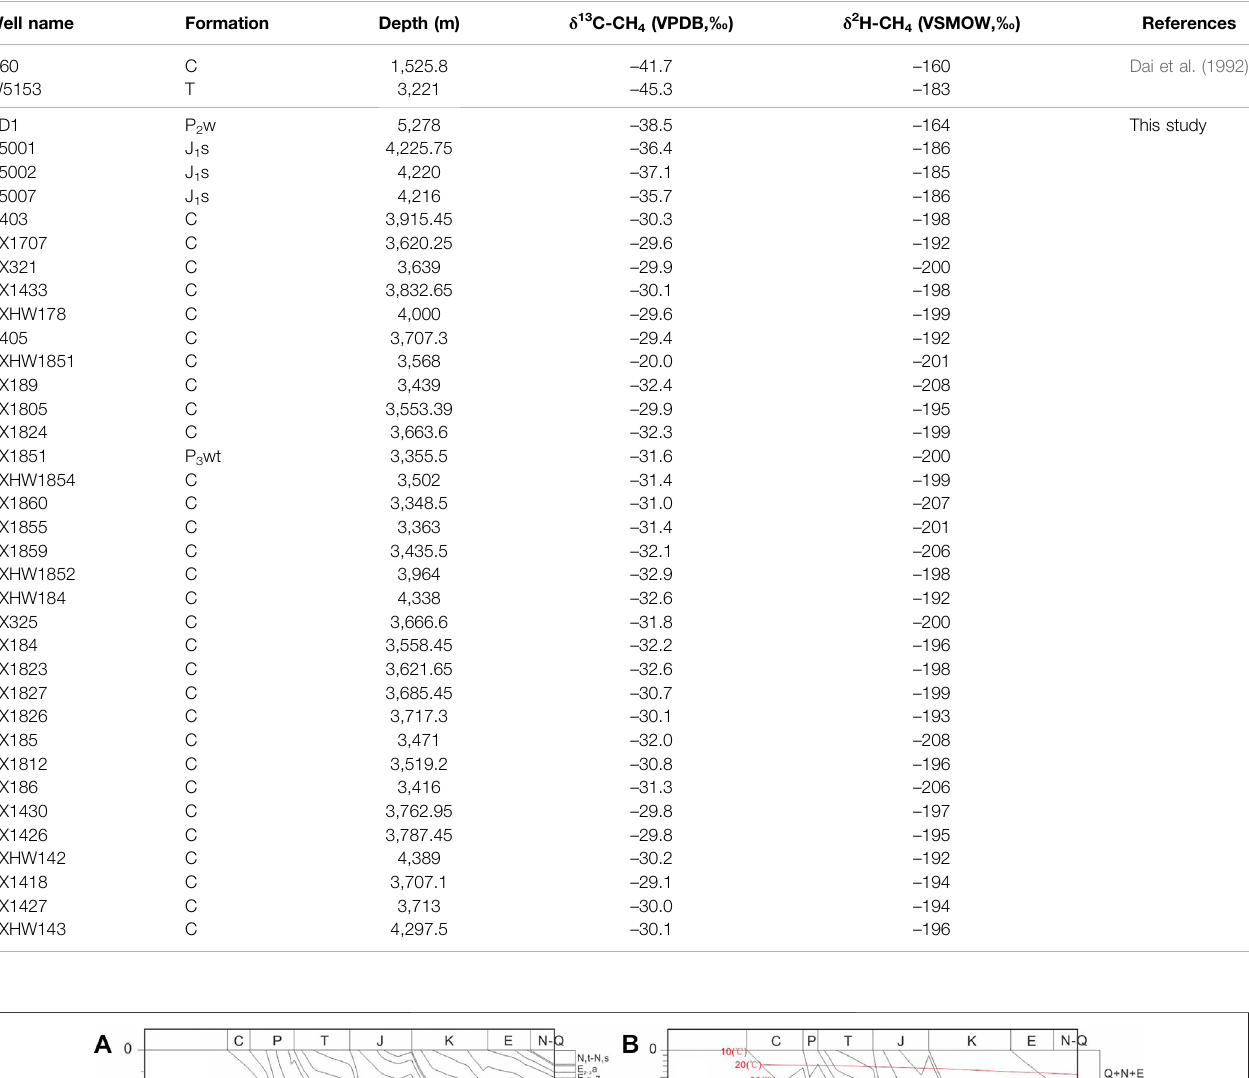
TABLE 2 | Stable hydrogen isotopes of natural gases in the Junggar Basin.